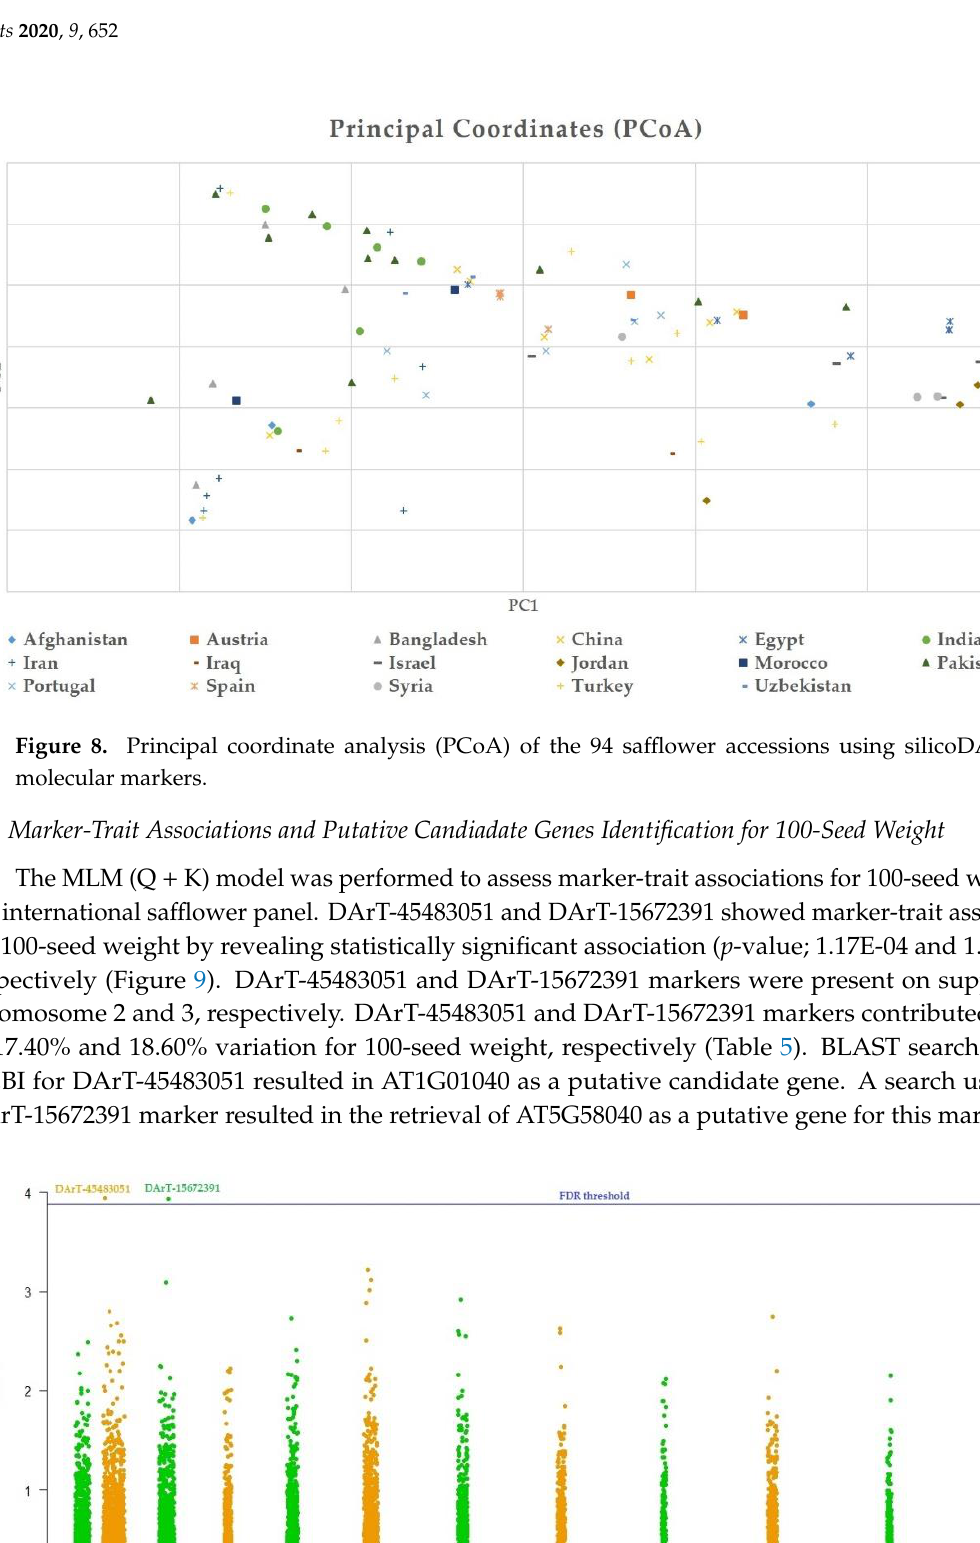
Figure 9. Pseudo manhattan plot for 100-seed weight in world safflower panel. DArT-45483051 and DArT-15672391 were considered statistically (FDR thresholds p = 0.01) associated with this trait. Table 5. Marker-trait associations of the 100-seed weight with its associated markers in international safflower panel of 94 accessions. Trait Markers p -Value R 2 Putative Gene